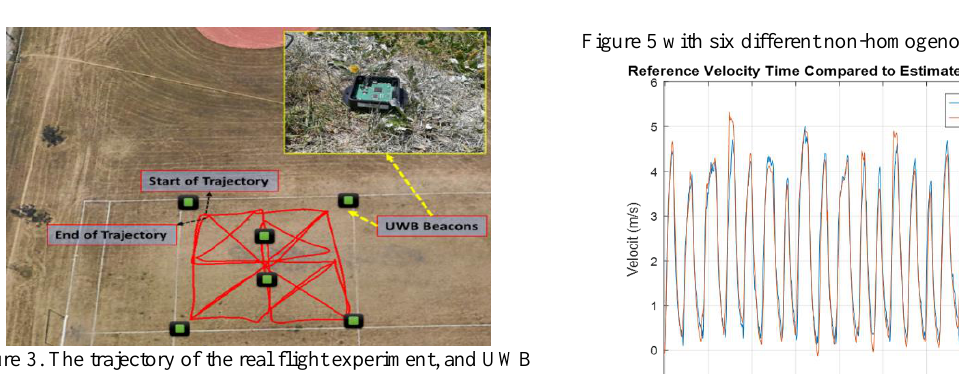
Figure 5 with six different non-homogenous configurations.